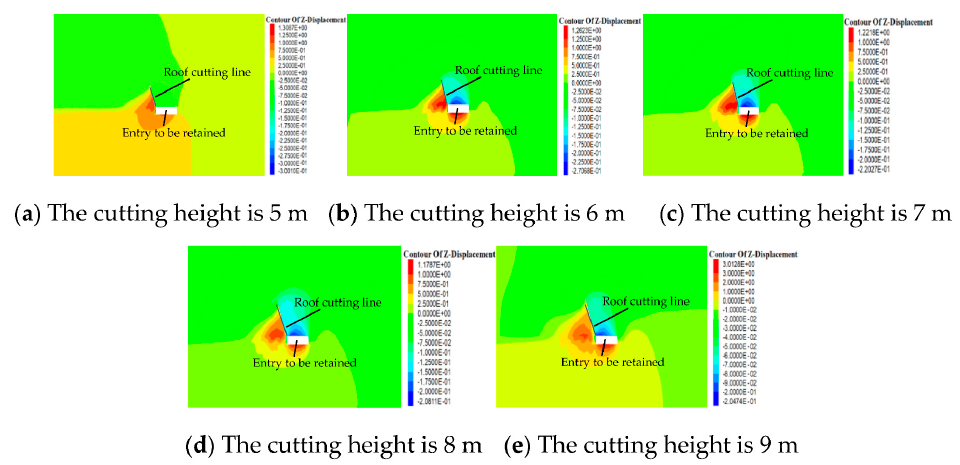
Figure 8. Vertical displacement of roadway surrounding rock under different cutting heights.